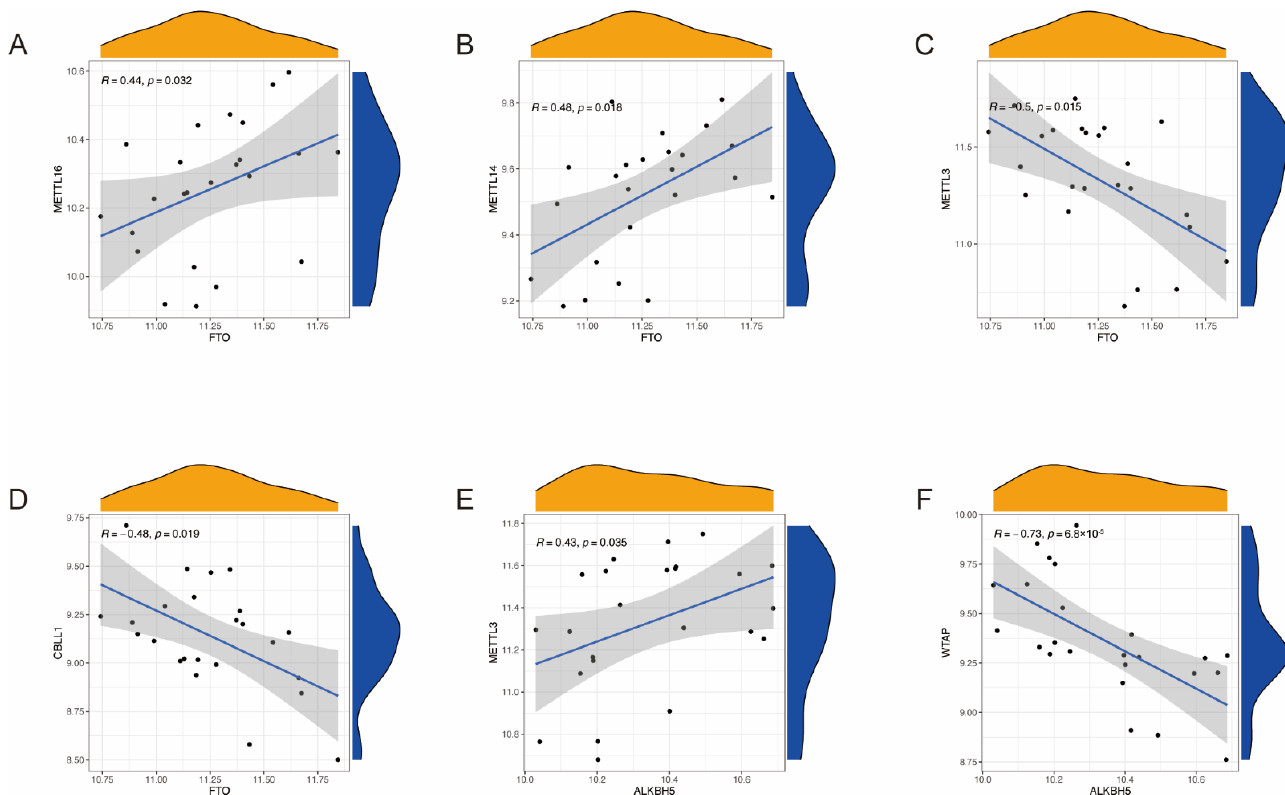
Figure 3. Correlation between writers and erasers in RSA. ( A – D ) Writer genes: METTL16 , METTL14 , METTL3 , and CBLL1 ; eraser gene: FTO . ( E , F ) Writer genes: METTL3 and WTAP ; eraser gene: ALKBH5 .